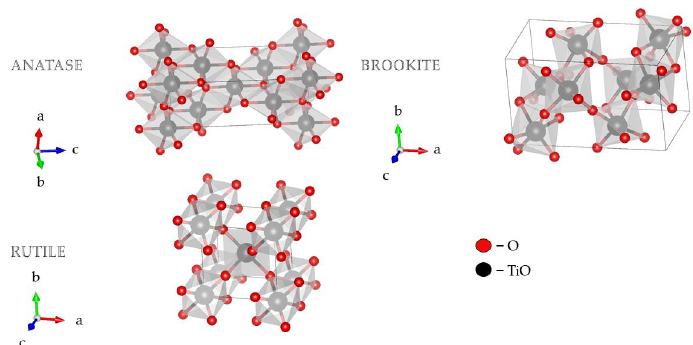
Figure 1. 3D visualization crystal structures of TiO 2 using visualization for electronic and structural analysis (VESTA) [33].